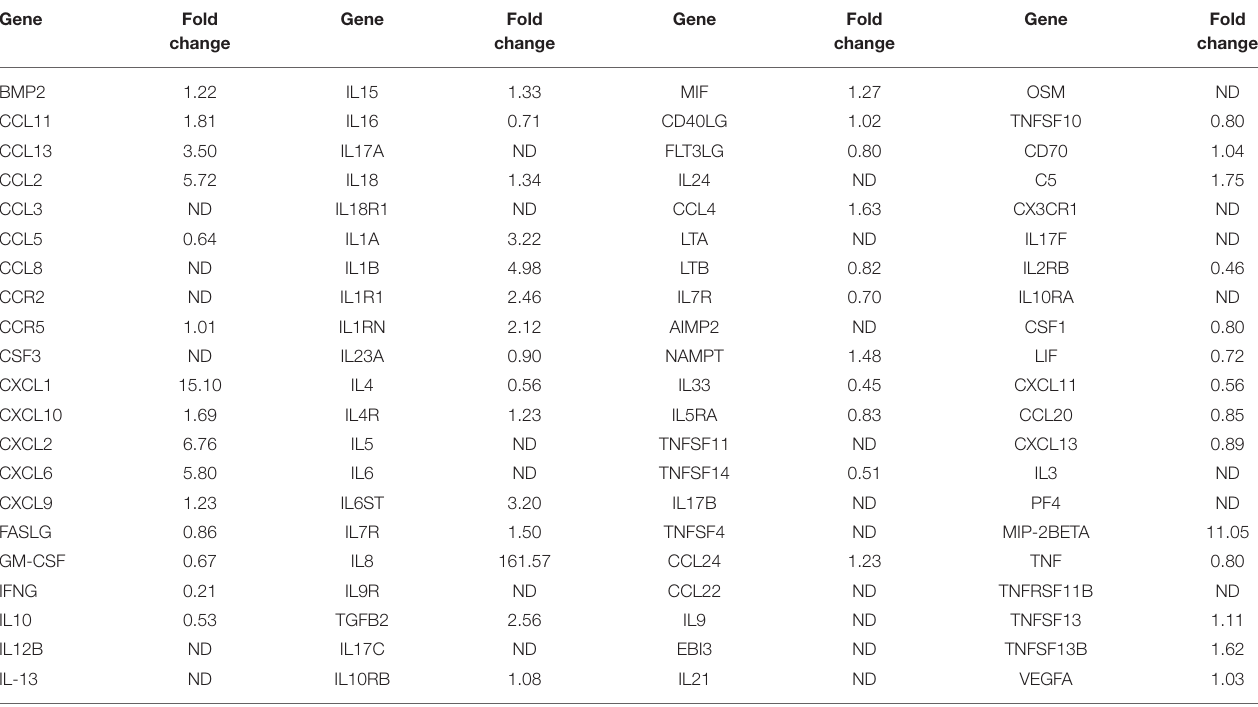
TABLE 4 | Transcriptional profile of the cytokines and chemokines in the large colon of the horses with large colon displacement and volvulus; 84 genes of the RT 2 Profiler TM PCR Array Horse Cytokines & Chemokines were reported.